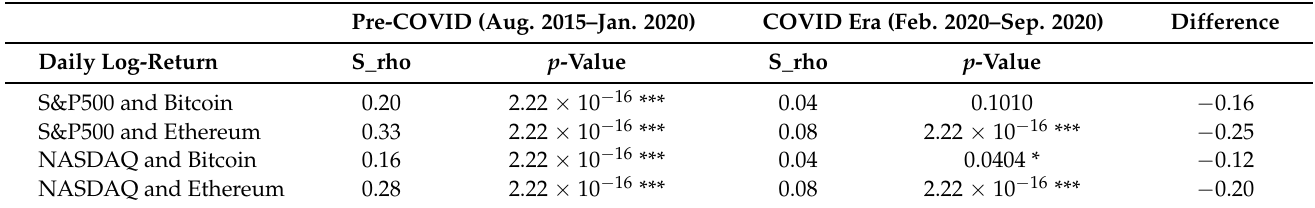
Table 2. Test equality of univariate densities: cryptos and stocks.